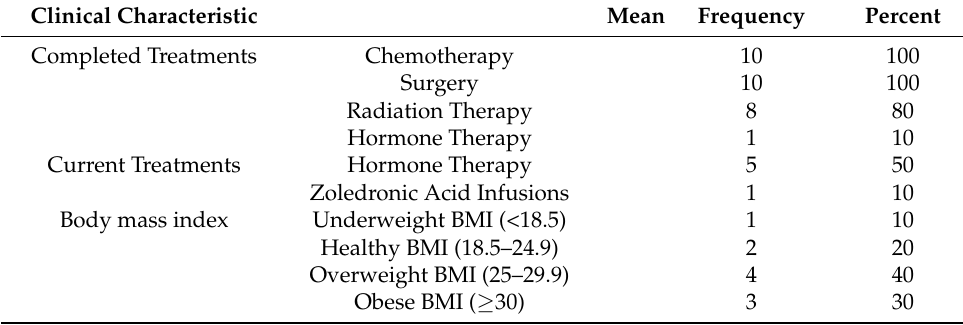
Table 4. Clinical characteristics of the participants recruited from ACE.